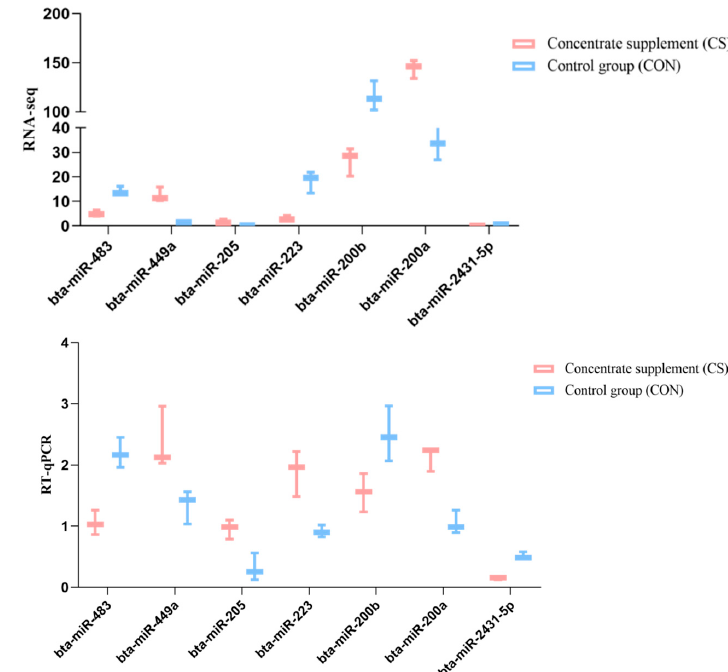
Figure 5. Validation for the RNA sequencing data by qRT-PCR.RNA-Seq results ( A ): qRT-PCR results ( B ): The results are presented as the mean ± SD ( p < 0.05).